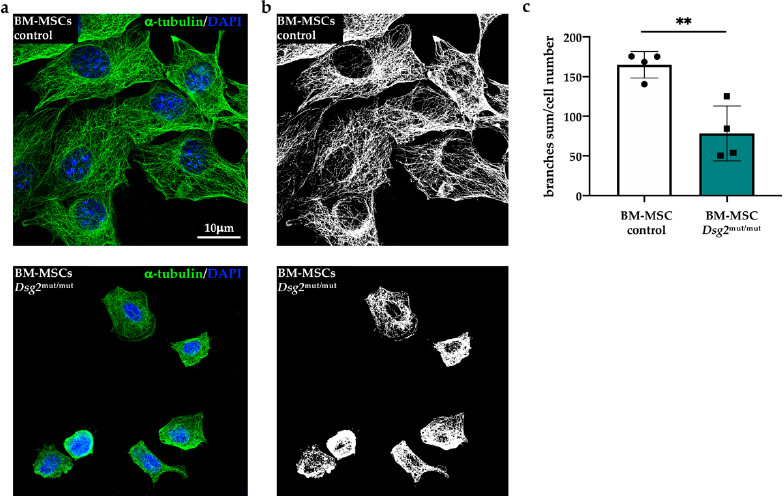
Figure 3. AC-linked Dsg2 variant affects microtubule organization in bone marrow mesenchymal stromal cells . ( a ) Super-resolution confocal IF analysis of cultured BM-MSCs isolated from control or Dsg2 mut/mut mice. Cells were stained with anti- α -tubulin antibody (green signal). Nuclei were counterstained with DAPI (blue signal). ( b ) Skeletonized images shown in ( a ). ( c ) Quantification of total number of microtubule branches/cell in control and AC BM-MSCs. A total of 30 cells for each study group were analyzed. Bars represent mean, and error bars represent standard deviation (SD). ** p ≤ 0.01.